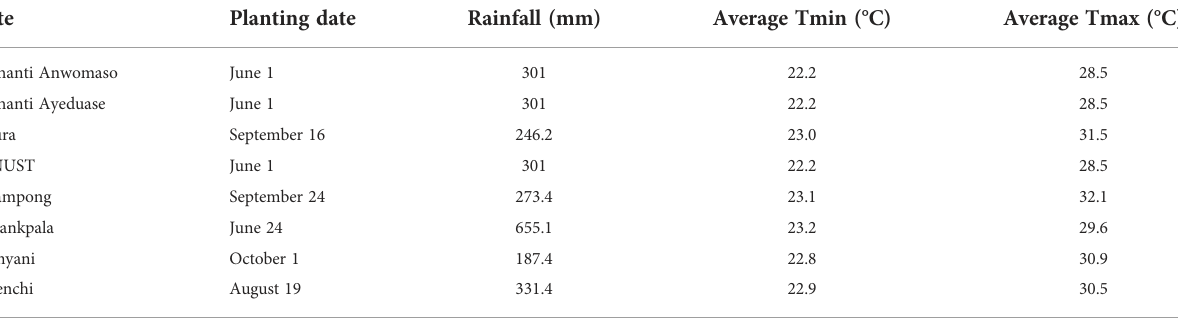
TABLE 3 Sowing dates, total rainfall, and the average minimum temperature and maximum temperatures during the experimental period at the study sites during 2020. Site Planting date Rainfall (mm) Average Tmin (°C) Average Tmax (°C)